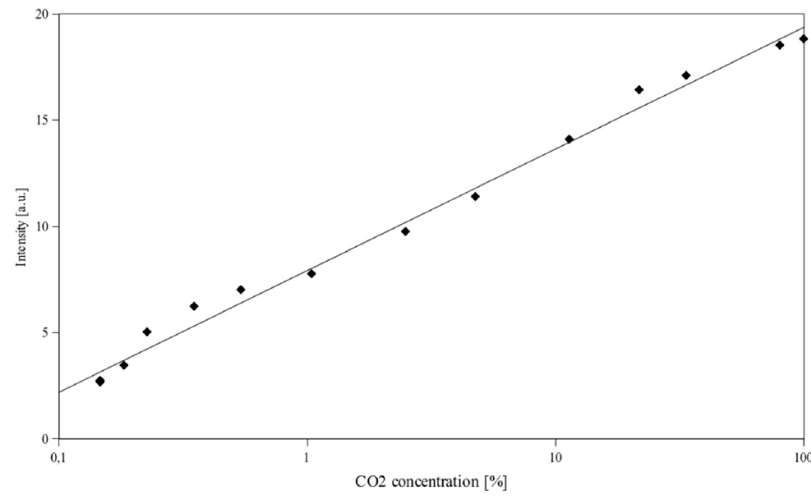
Figure 2. Dependence between the intensity of light transmitted through an optical fibre sensor containing thymol blue as an indicator dye and the CO 2 concentration.